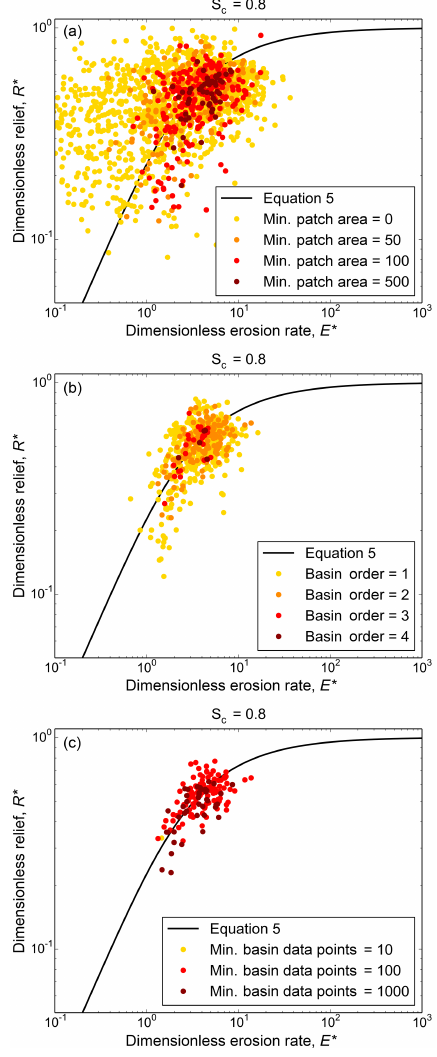
Figure 9. Comparison of the influence of changing spatial averag- ing method on the interpretation of E ∗ R ∗ data for Gabilan Mesa. (a) Variations in the minimum patch area threshold from 0 (no threshold) to 500 pixels highlighting the reduction in noise when a minimum patch area is applied. (b) Increasing the basin steam or- der, which reduces variance in the data, as bigger basins are sets containing basins of smaller orders, dampening any extreme val- ues. (c) Variations in the minimum basin pixels threshold. Outly- ing basins have very few data points, so they are influenced more strongly by single atypical